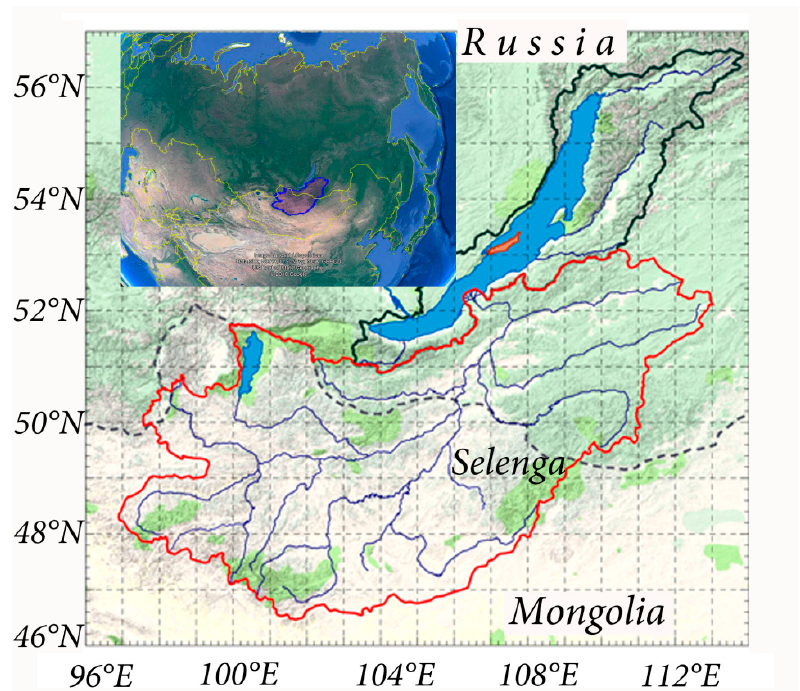
Figure 1. Lake Baikal Basin (solid red and solid black lines). Selenga River Basin (solid red line). State boundary between Russia and Mongolia (dashed gray line).